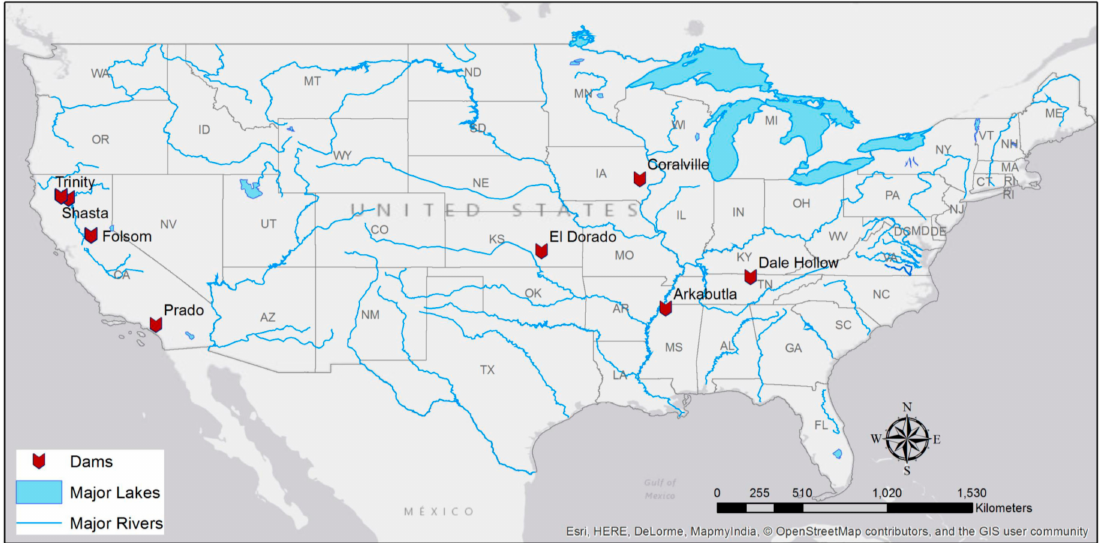
Figure 7. Location of the selected reservoirs over the CONUS. Table 4. List of the selected reservoirs and employed